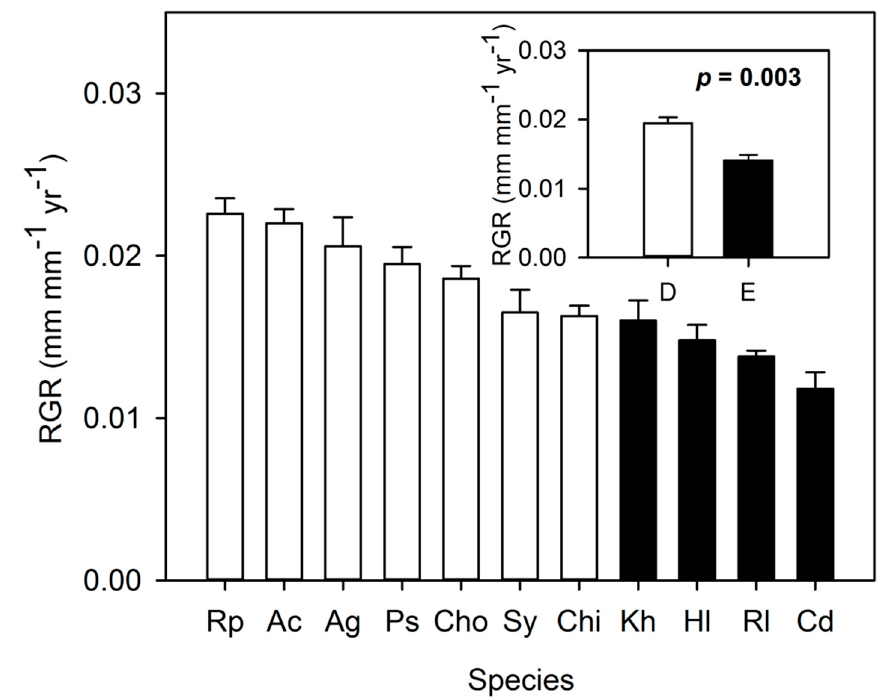
Figure 2. Relative growth rate (RGR) values in deciduous (open bar) and evergreen (filled bar) liana species. The insert indicates the difference in RGR between deciduous (D) and evergreen (E) lianas. See Table 2 for species codes. Data were means ± SE.